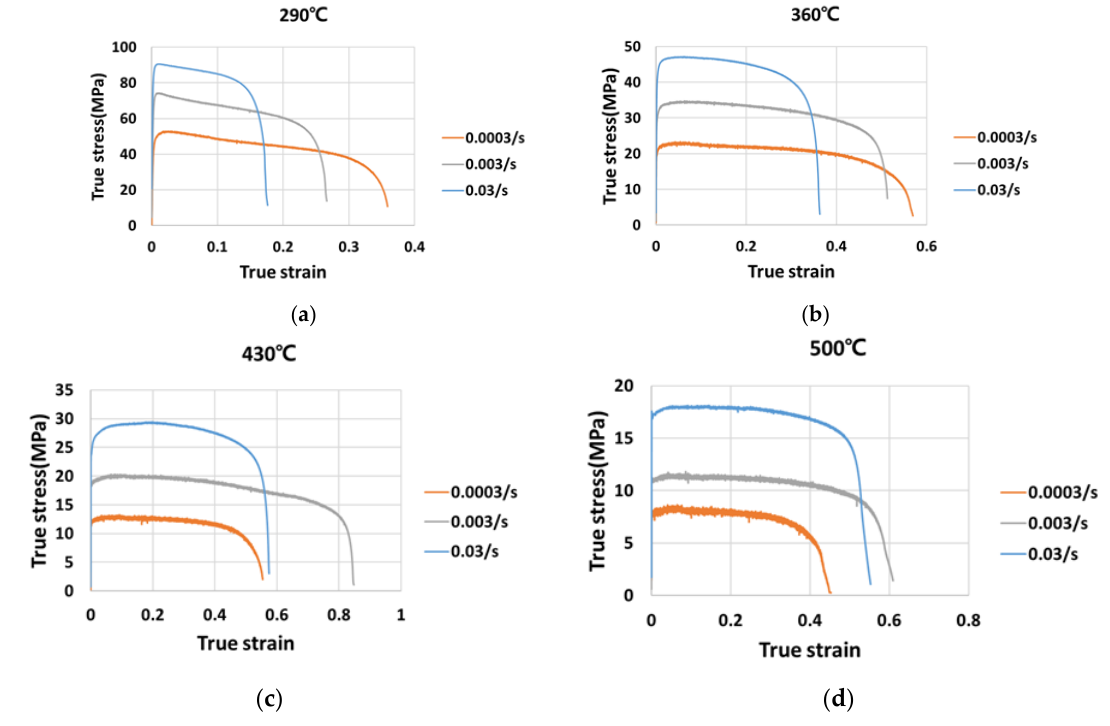
Figure 4. True stress–strain curves at ( a ) 290 °C, ( b ) 360 °C, ( c ) 430 °C, and ( d ) 500 °C.